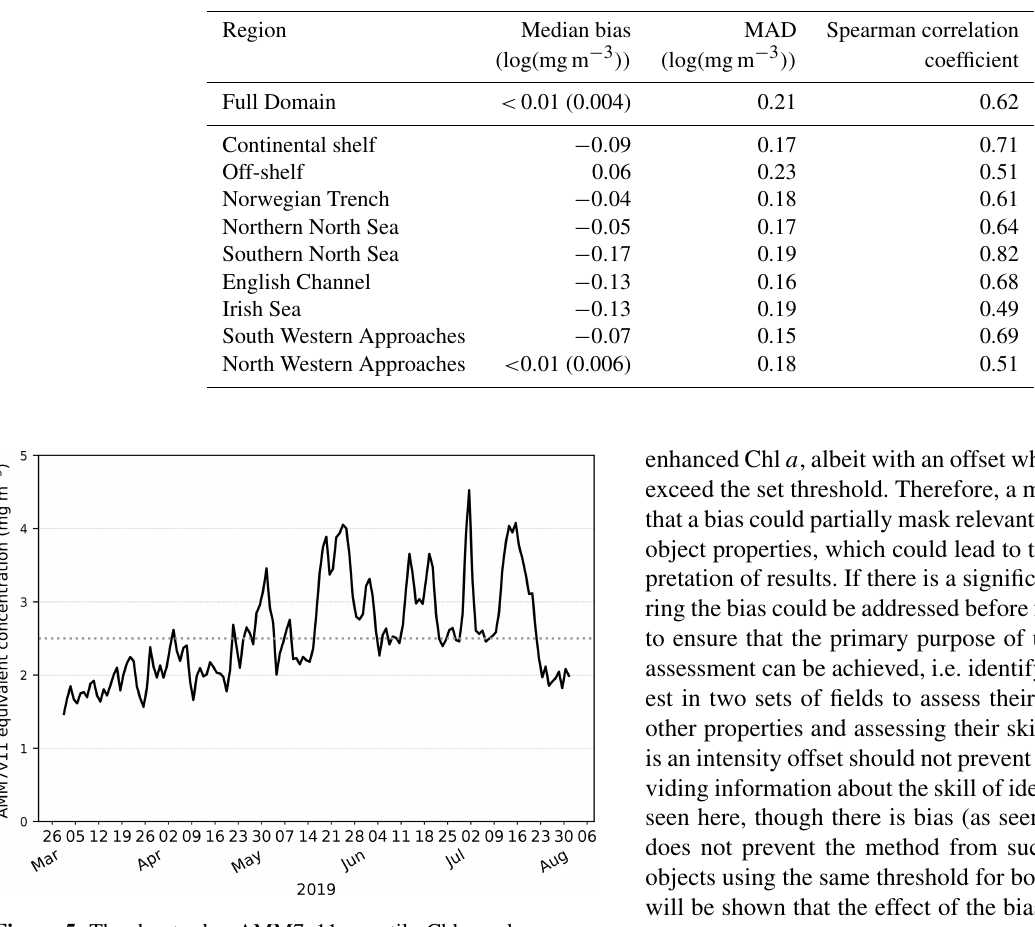
Figure 5. The day-to-day AMM7v11 quantile Chl- a value corre- sponding to the L4 product quantile representing 2.5mgm − 3 de- rived from the L4 daily CDFs. The mean AMM7v11 Chl- a equiva- lent quantile value for the 2019 season is 2.9mgm − 3